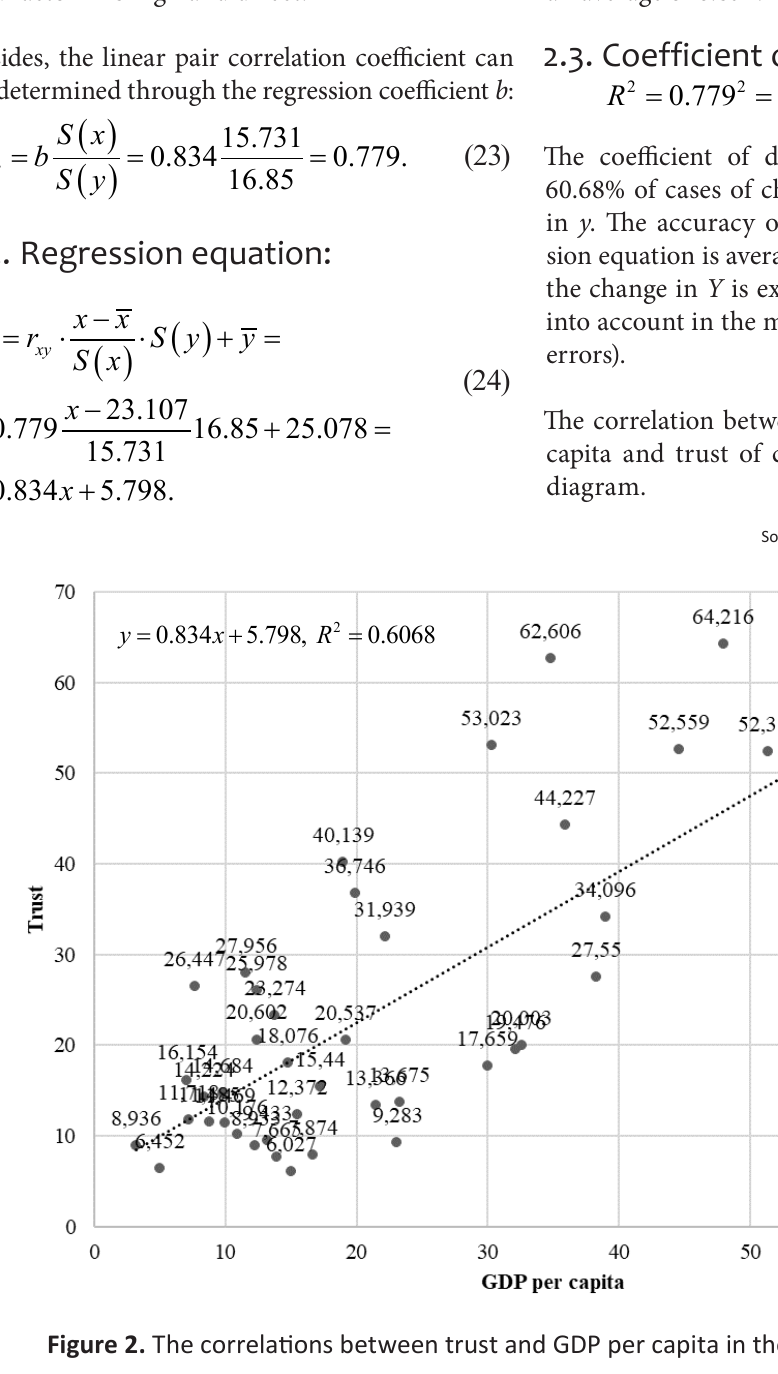
Figure 2. The correlations between trust and GDP per capita in the European